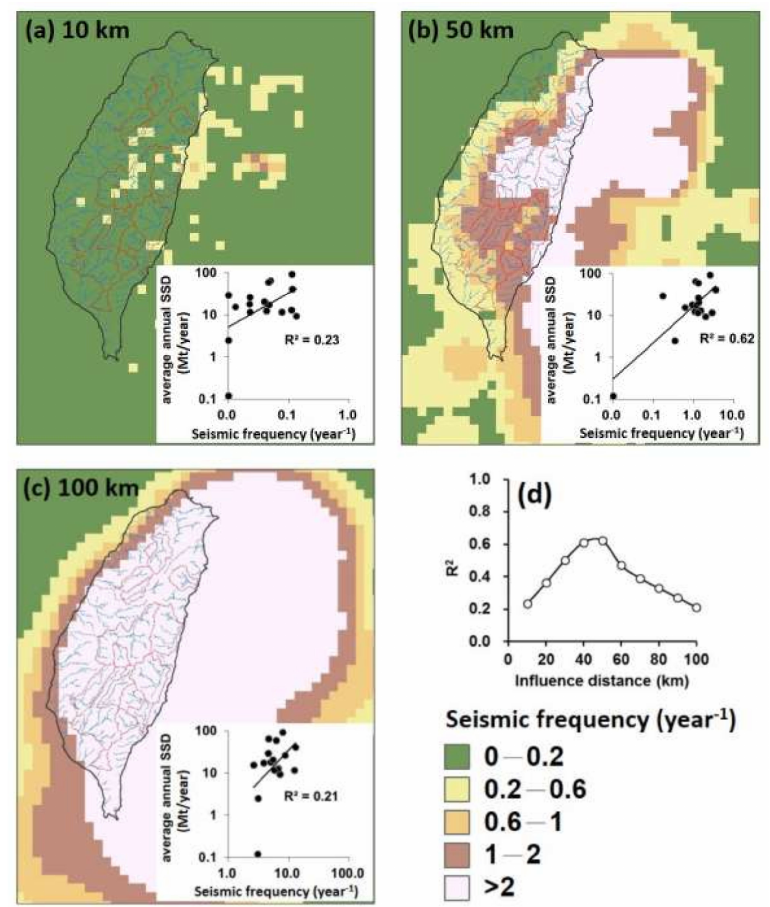
Figure 5. Distribution of seismic frequencies, and relationships between seismic frequencies and the averagely annual SSD under different influence distances: ( a ) 10 km, ( b ) 50 km, and ( c ) 100 km. ( d ) Variation of determination coefficients at different influence